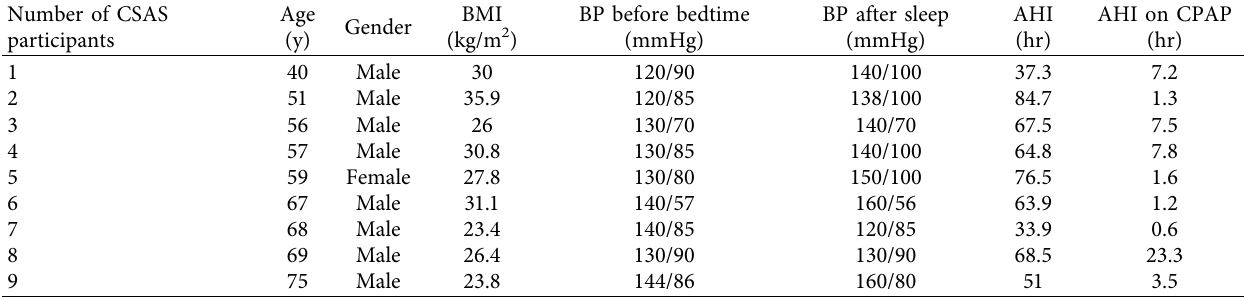
Table 1: The demographic and basic data for the nine CSAS participants.